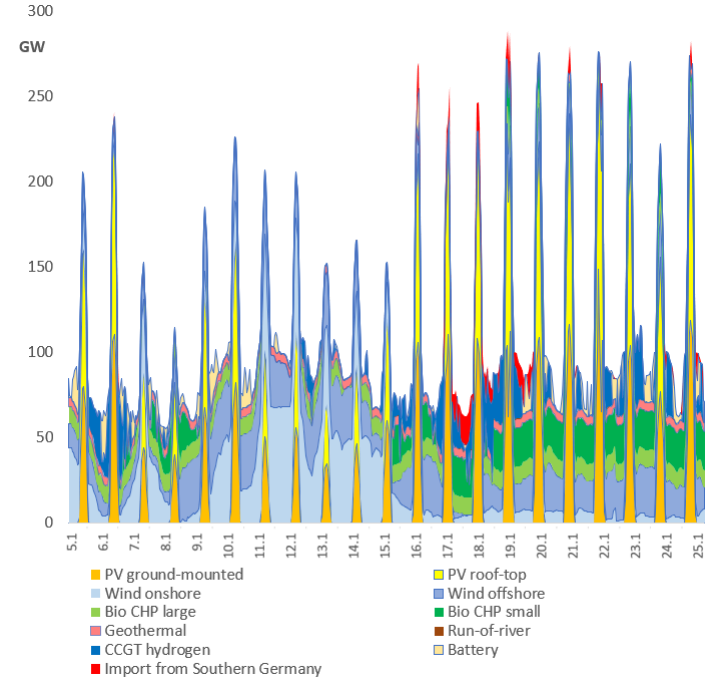
Figure 1. Load coverage in northern Germany in January 2017. Under extremely weak wind conditions, as on 18 January, coverage is made up by bioenergy, hydrogen, and by imports from southern Germany.